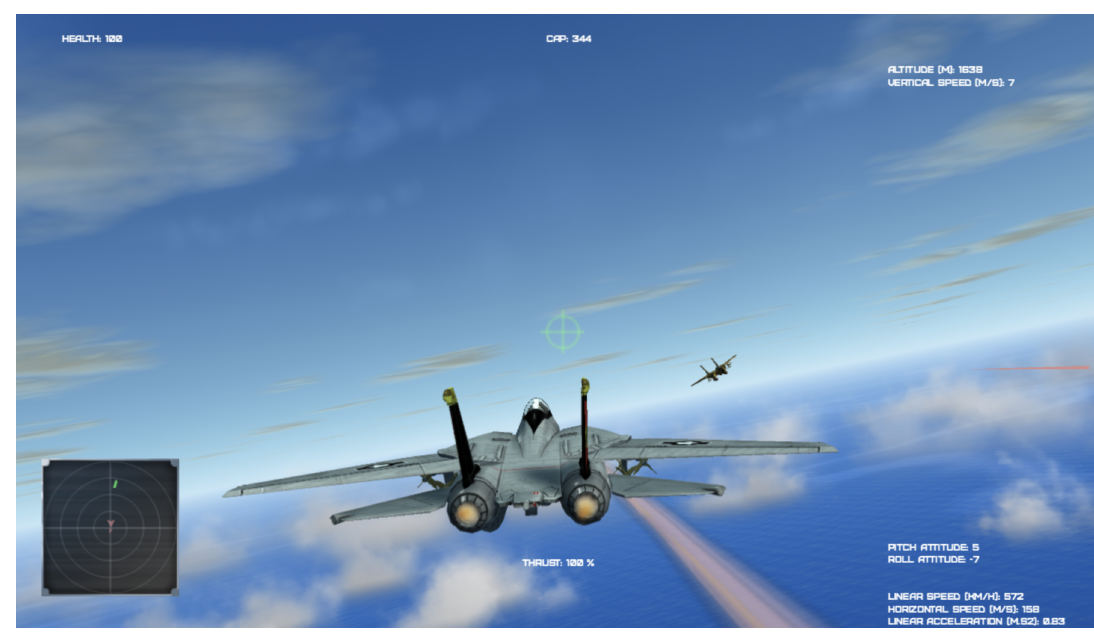
Figure 4. Main interface of the air combat simulation